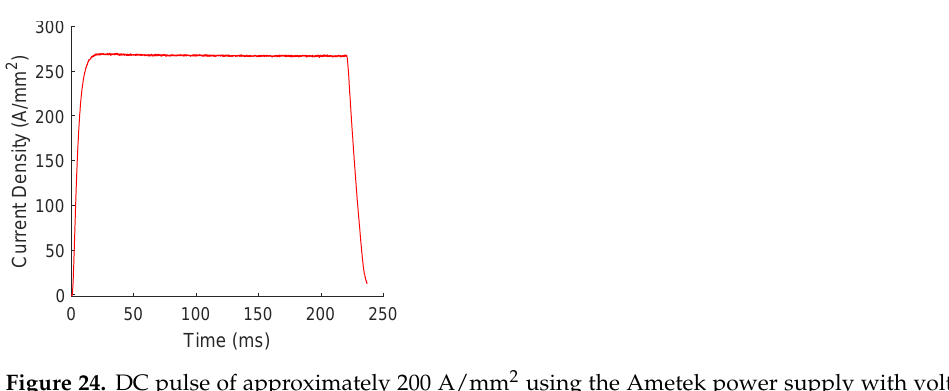
Figure 24. DC pulse of approximately 200 A/mm 2 using the Ametek power supply with voltage control; Water-cooled test condition.